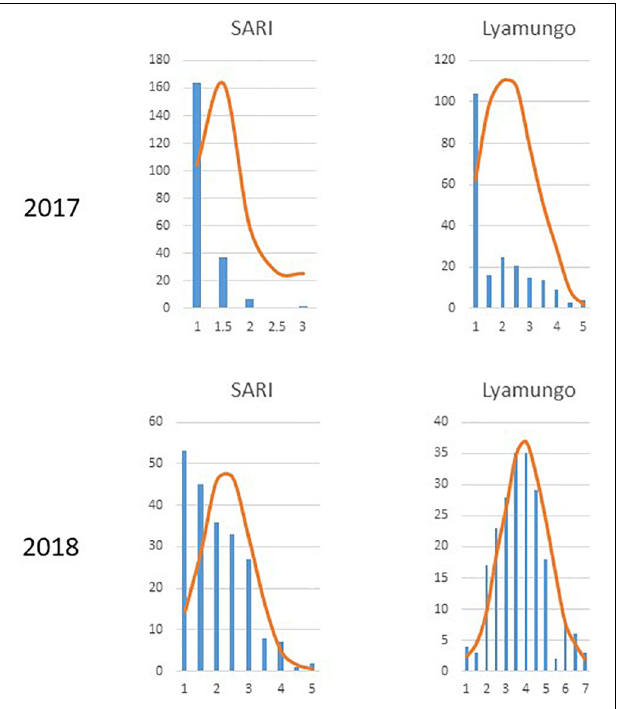
FIGURE 2 | Distribution of phenotypic data across 211 common bean genotypes at each of two locations in 2017 and 2018.